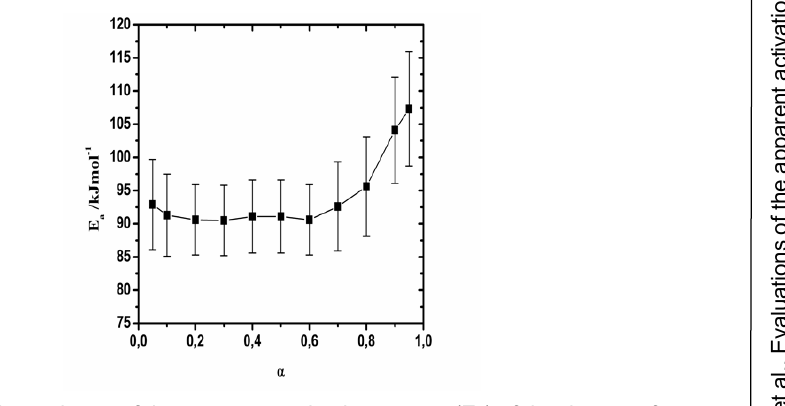
Figure 7 – The dependence of the apparent activation energy (E a ) of the degree of con- version ( α ) determined using the differential isoconversional method for the reduction process of nickel oxide (NiO) under hydrogen